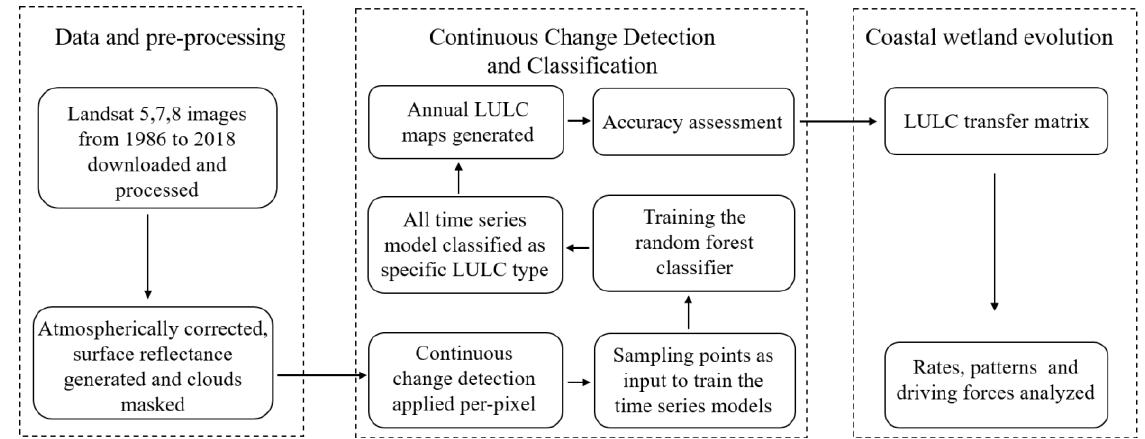
Figure 2. Overall flowchart of this study.